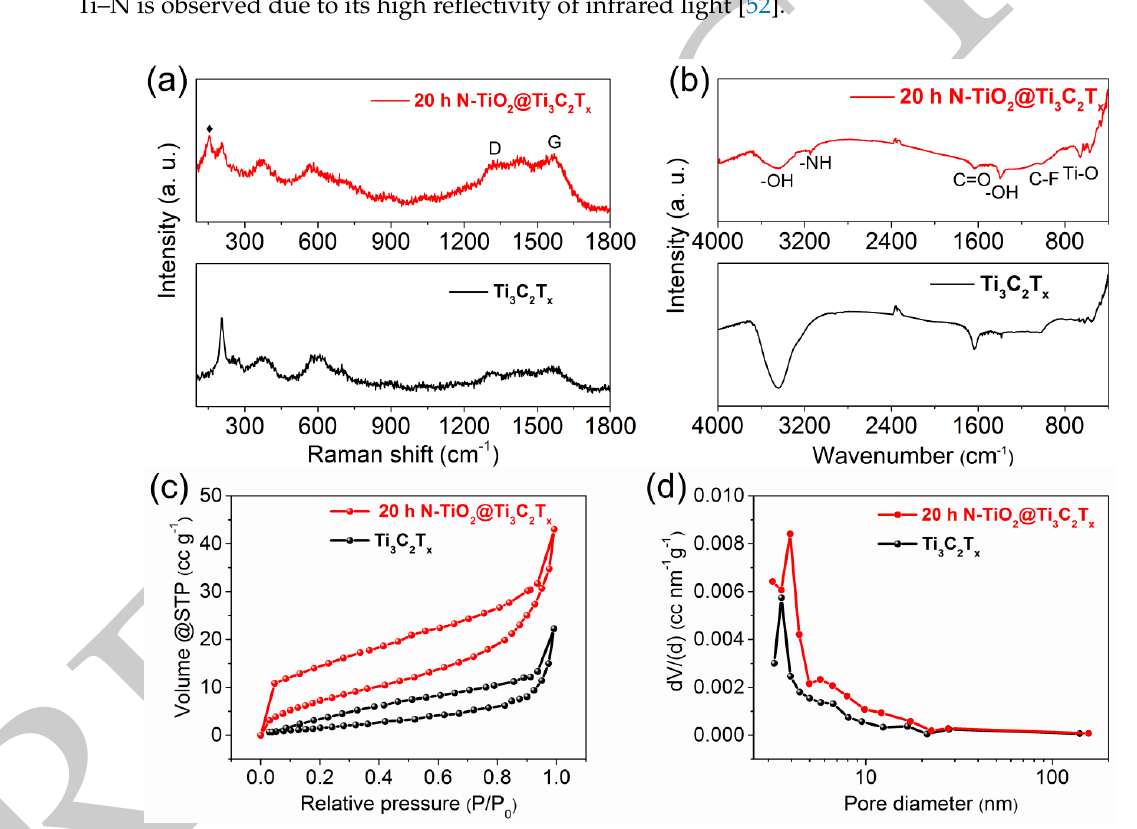
Figure 5. ( a ) Raman spectra, ( b ) Fourier transform infrared spectroscopy (FTIR) spectra, ( c ) Nitrogen (77 K) adsorption-desorption isotherms and ( d ) the corresponding pore size distribution curves of Ti 3 C 2 T x and 20 h N-TiO 2 /TiN/Ti 3 C 2 T x .